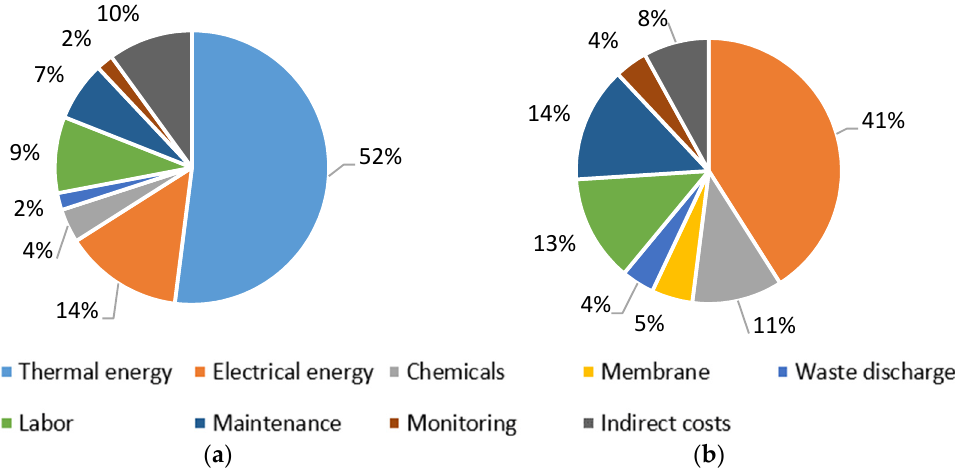
Figure 11. OPEX cost of desalination plants: ( a ) thermal plants; ( b ) RO plants [8] .